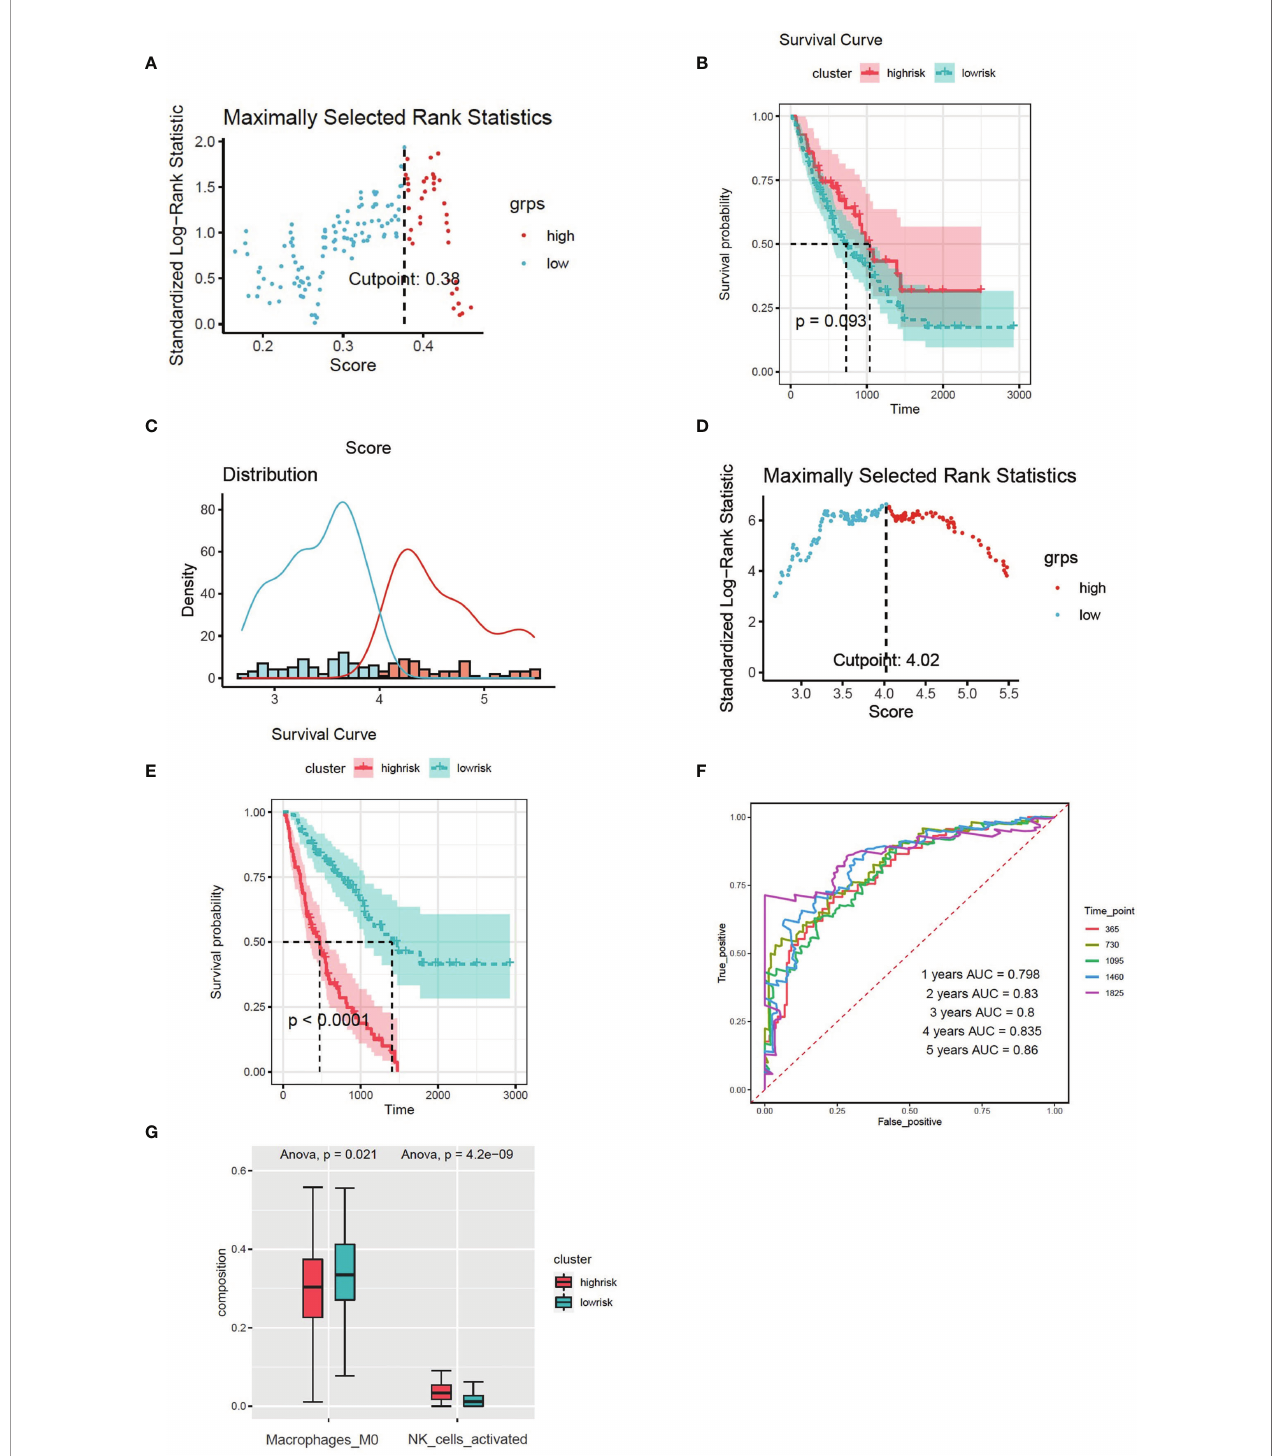
FIGURE 6 | (A) The cut-off point with the maximum standard log-rank statistic was marked with a vertical dashed line. (B) Kaplan – Meier plot of overall survival in two clusters based on the in fi ltration of M0 cells. (C) Histogram based on maximally selected rank grouping. (D) The cut-off point with the maximum standard log- rank statistic was marked with a vertical dashed line. (E) Kaplan – Meier plot of overall survival in two clusters based on the combined model (combined risk score). (F) The ROC curve in the combined risk models. (G) The in fi ltration of activated NK cells and M0 cells in two clusters based on the combined risk